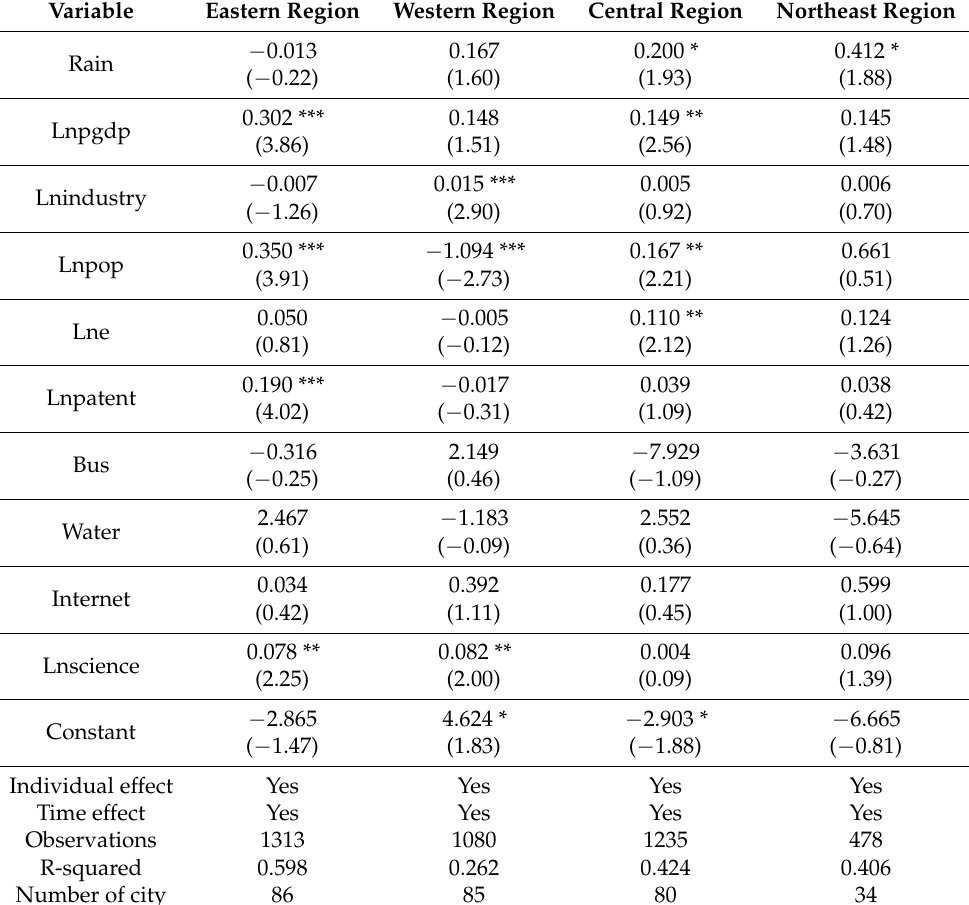
Table 4. Heterogeneity analysis based on different